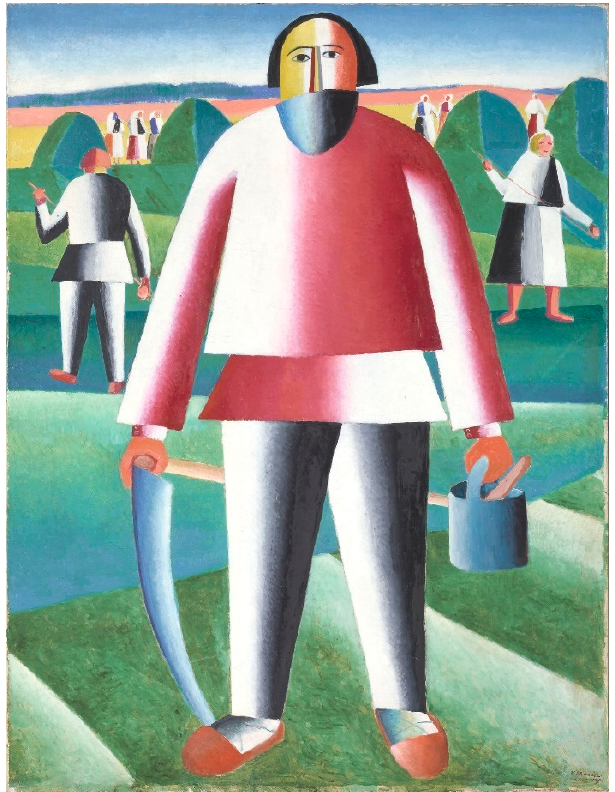
Figure 4. Kazimir Malevich. A peasant at work.